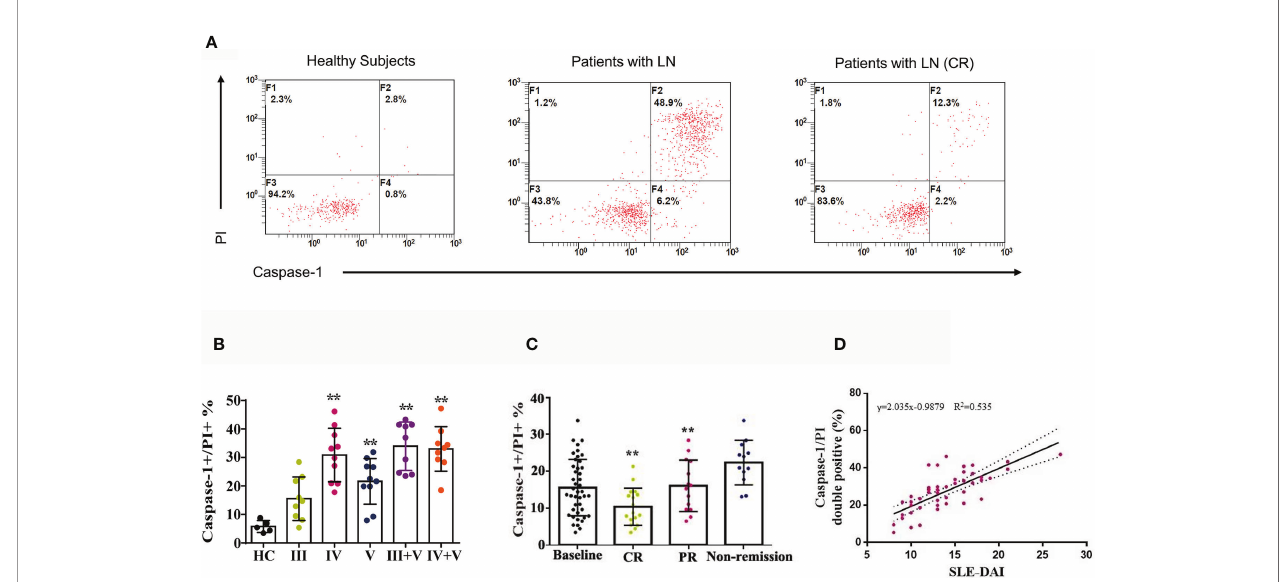
FIGURE 4 | Combination therapy attenuated caspase-1-mediated pyroptosis in LN patients. (A) FACS of caspase-1/PI double positive cells in peripheral blood of LN patients treated with or without combination therapy. (B) Quanti fi cation of caspase-1/PI double positive cells in peripheral blood of type III, IV, V, III+V and IV+V LN patients and heathy subjects. (C) Quanti fi cation of caspase-1/PI double positive cells in peripheral blood of LN patients at baseline, CR, PR and non-remission after combination therapy. (D) Correlation analysis of caspase-1/PI double positive cells ratios with SLE-DAI. ** p < 0.01. FACS, fl uorescence-activated cell sorting;